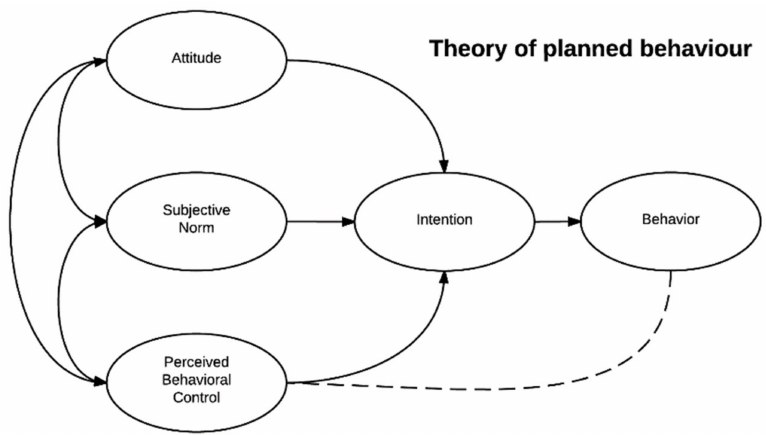
Figure 2. The theory of planned behavior. Reproduced from Ajzen, I., From Intentions to Actions: A Theory of Planned Behavior; published by Springer,